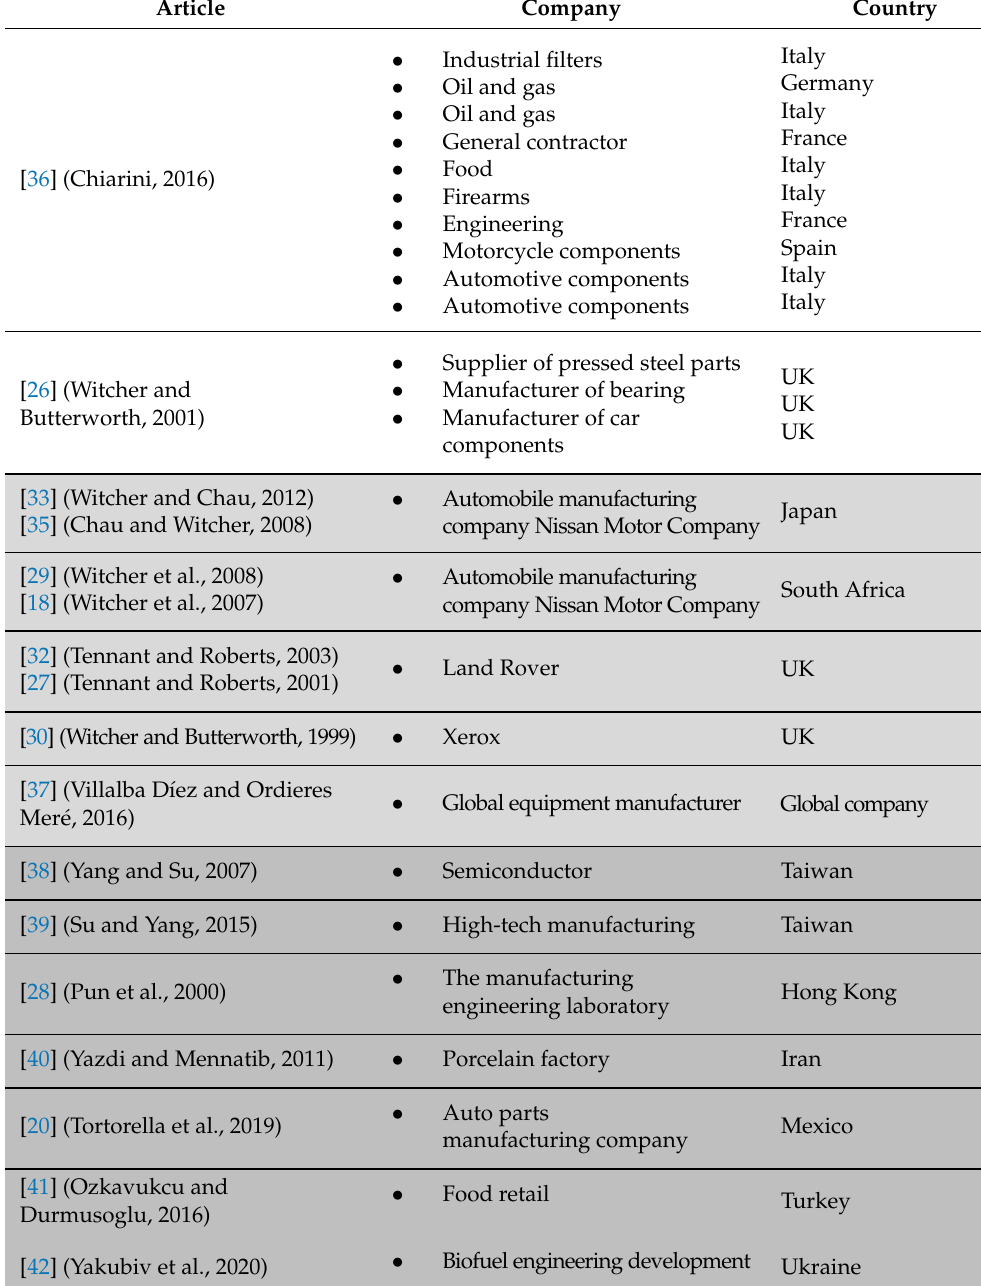
Table 5. Large companies (first group, second group, and third